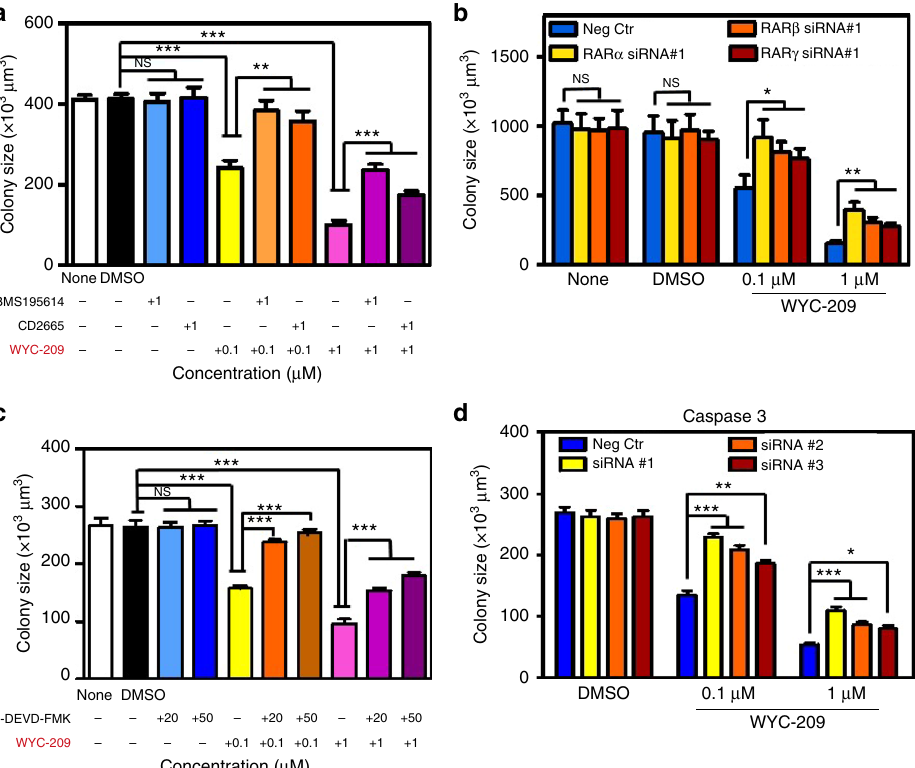
Fig. 6 WYC-209 inhibits TRCs growth by binding RA receptors and via the caspase 3 pathway. a Control B16-F1 cells were cultured in 90-Pa fi brin gels treated with RA receptor antagonists for 3 h, then treated with 0.1 or 1 μ M WYC-209, and cultured for 5 days. Summarized colony sizes after drug treatments on day 5 were compared with DMSO groups. None: medium without drugs. DMSO: medium with 0.1% DMSO. BMS 195614: Retinoic acid receptor (RAR) α -selective antagonist. CD 2665: selective RAR β / γ antagonist. b Control B16-F1 cells were transfected with negative control (scrambled siRNA), RAR α , RAR β , or RAR γ siRNA #1 s, respectively, and were then re-plated in soft fi brin gels, and were treated with 0.1 or 1 μ M WYC-209. Summarized colony sizes after drug treatments on day 5 were compared with Negative control groups. None: medium without drugs. DMSO: medium